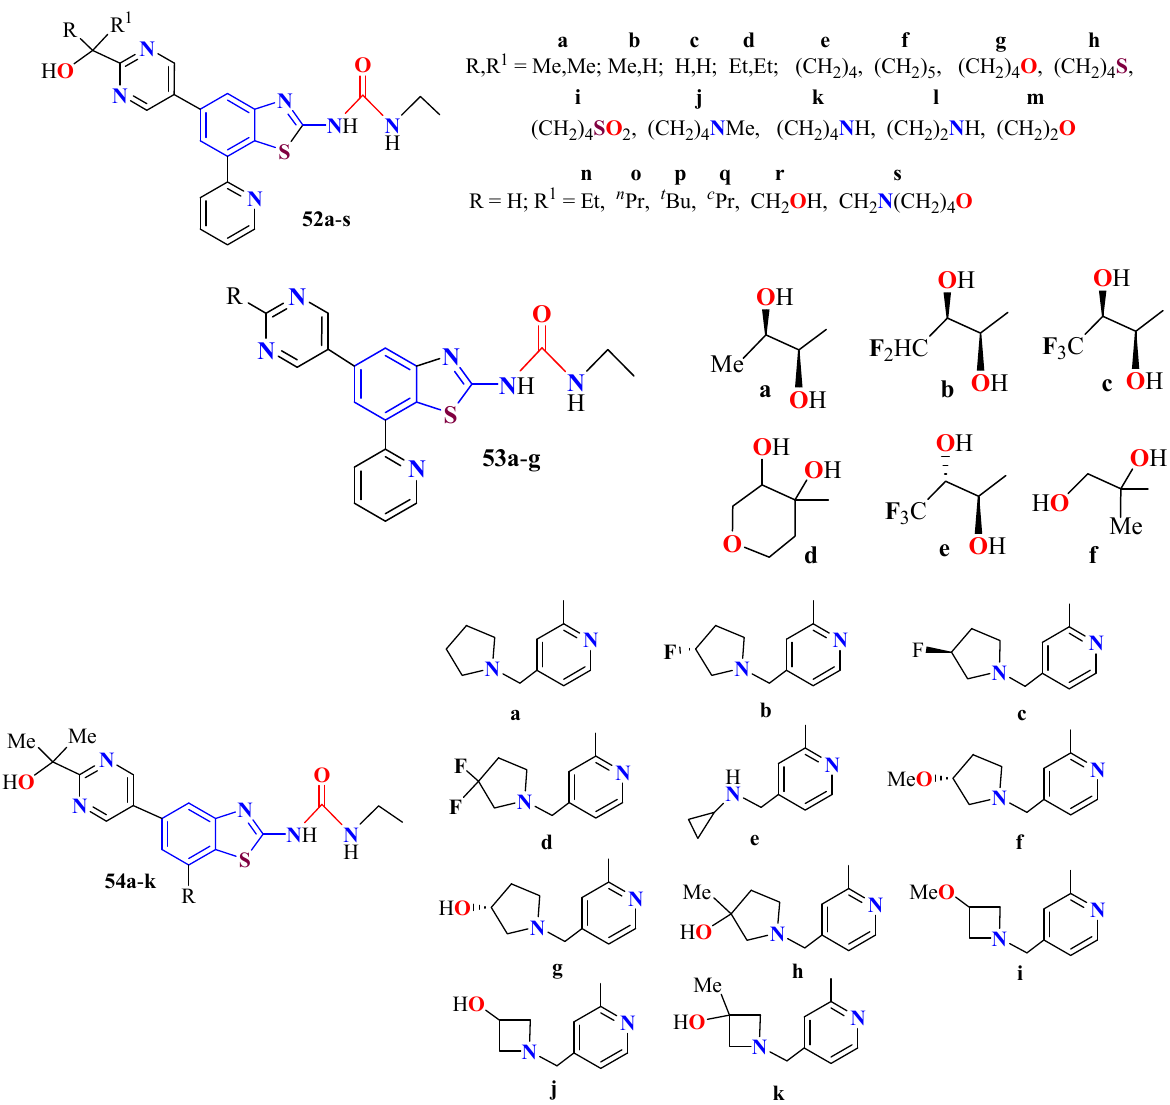
Figure 8. The 5-substituted alcohol-containing ethyl-UBTs 52a – s , 53a – g , and 54a – k . In a typical reaction, ortho -, meta -, or para -tolyl-isocyanates were treated with 2ABT in the presence of 1,4-dioxane at room temperature to synthetize three tolyl-UBTs 55a – c to evaluate their inhibitory effects on α -chymotrypsin enzyme, Figure 9 [147]. It was found the para -substituted N -(1,3-benzothiazol-2-yl)- N ′ -(4-methylphenyl) urea 55c derivative substantially inhibited α -chymotrypsin activity (IC 50 = 20.6 ± 0.06 μ M). Due to the presences of the bulky 1,3-benzothiazol-2-yl group at one nitrogen of the urea bridge, the activity is enhanced by the reduction of the steric hindrance in the order ortho > metha > para .